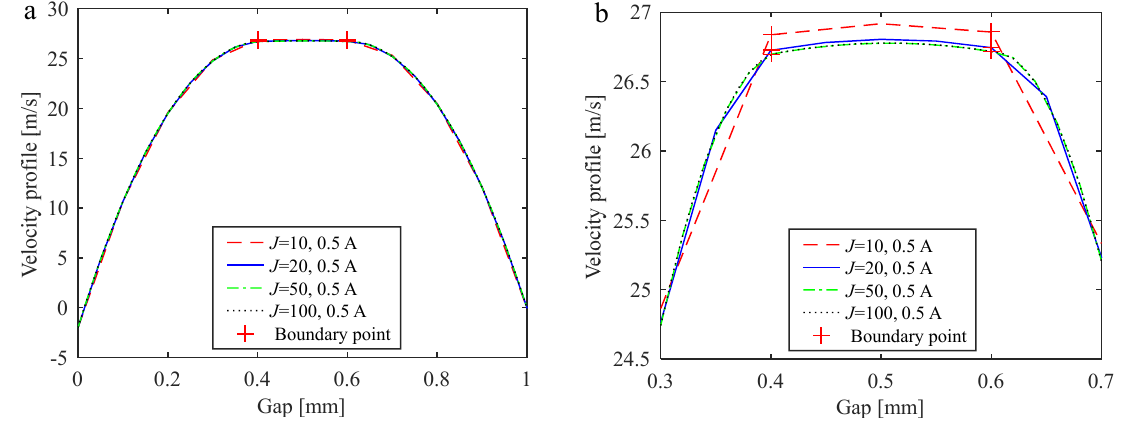
Figure 24. Peak velocity profiles of the inactivated region and its local enlargement for different mesh density under the excitation current of 0.5 A.